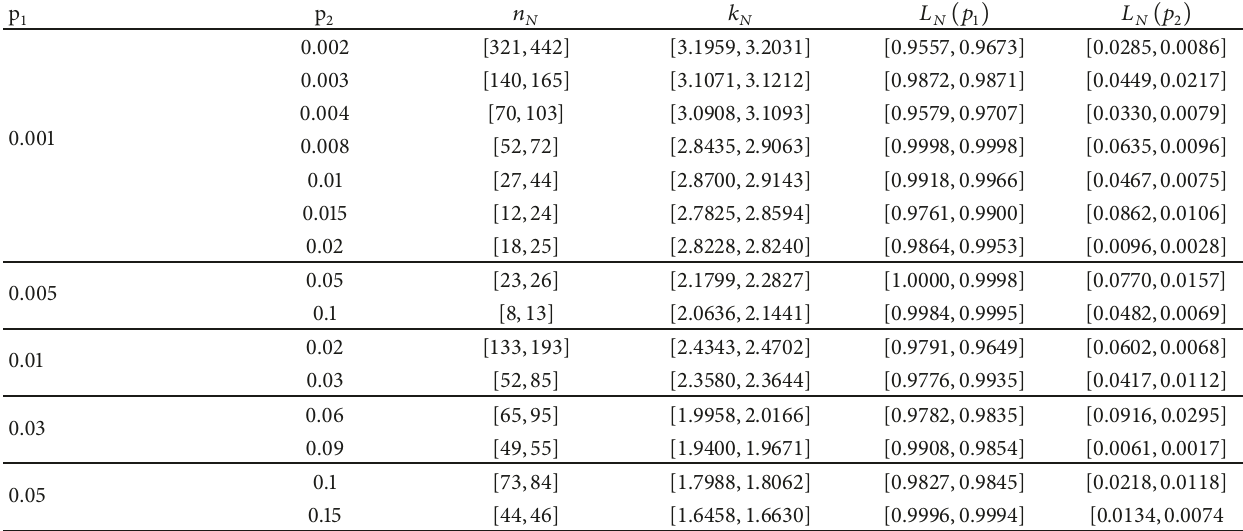
Table 3: The plan parameters when 𝛼 = 0.05 , 𝛽 =0.10, 𝑟 =6.